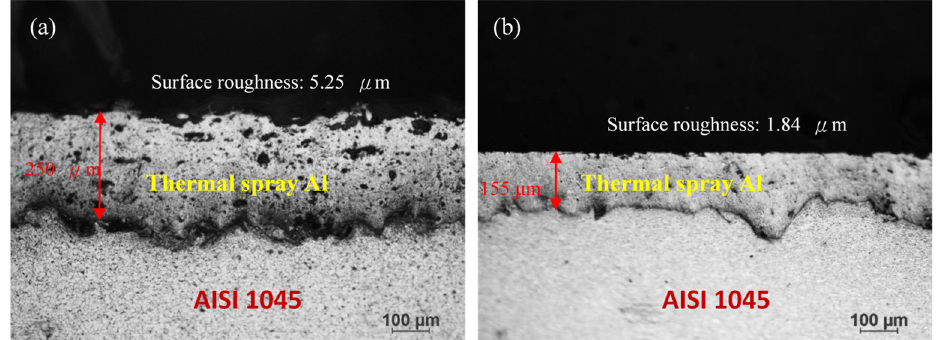
Figure 2. Optical micro-images of thermal spray Al on AISI 1045; ( a ) before hot rolling, and ( b ) after hot rolling.